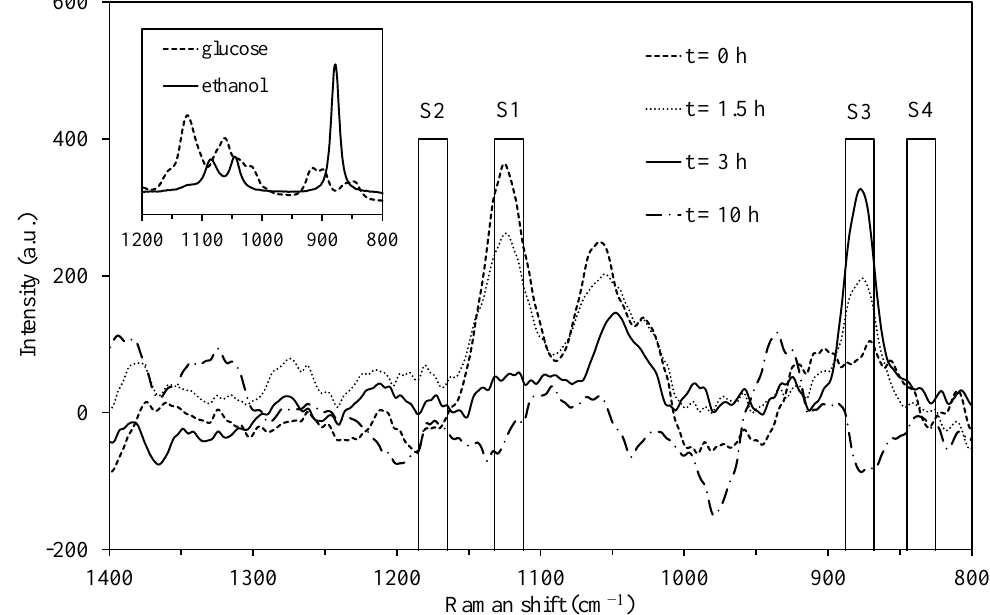
Figure 3. Raman spectra obtained during yeast fermentation and selected spectral regions (S1–S4) used for the MLR models. The spectra were corrected against the culture medium and inoculum without the initial carbon source glucose and offset-corrected by subtraction of a straight line. Top left: Raman spectra of 30 g L − 1 glucose and 10 g L − 1 ethanol in deionized water for comparison (background against deionized water).